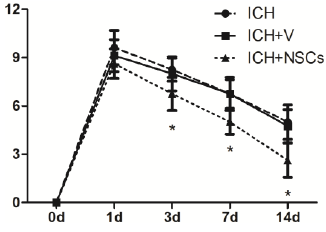
Figure 3. Behavioral functional test before and after ICH. Transplanted NSCs improve functional recovery after ICH at day 3, 7 and 14. ( n = 6 in each group) * p < 0.05 versus ICH and ICH + V.